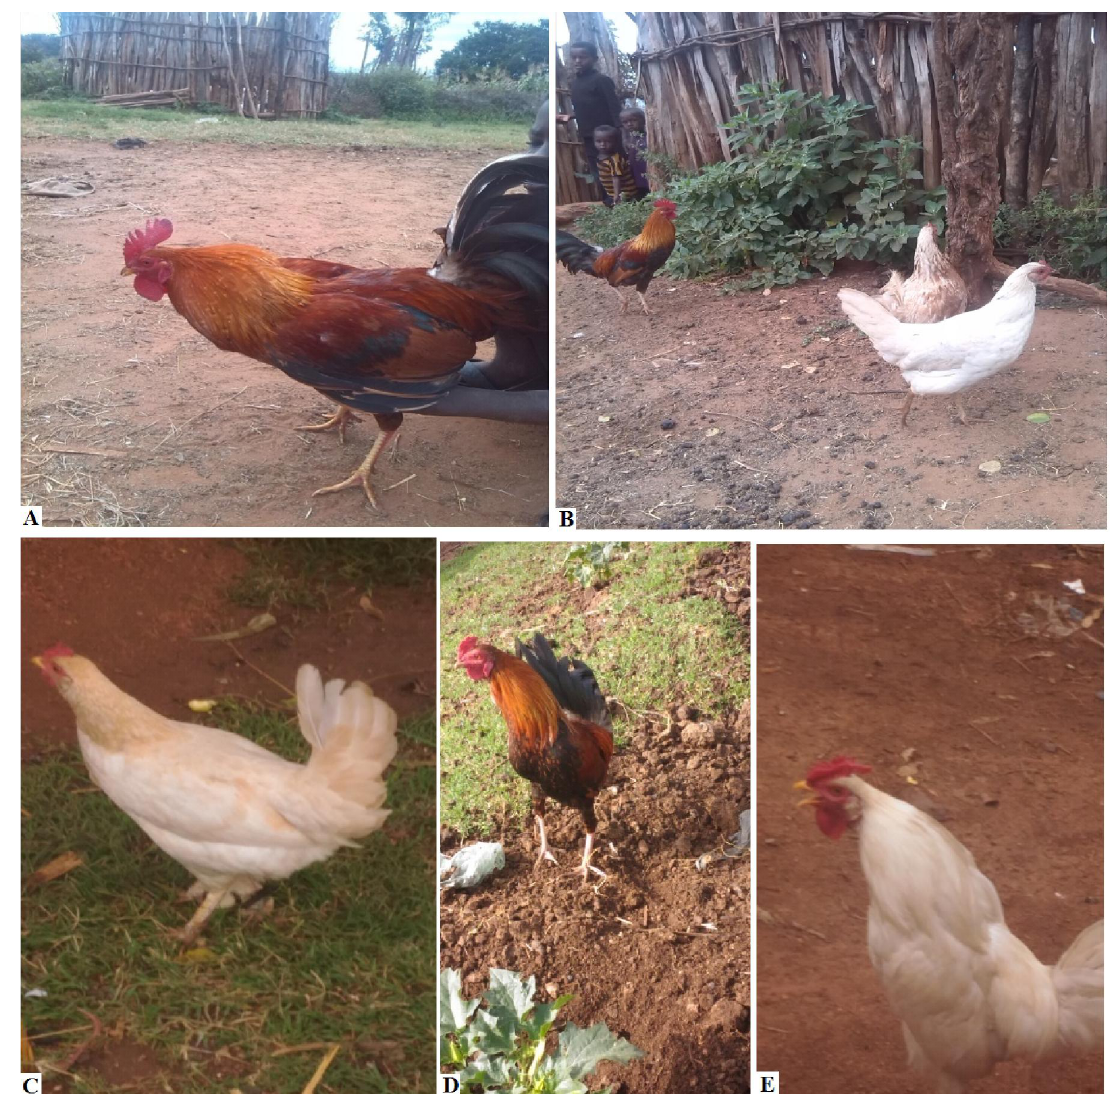
Fig. 2. Typical male and female chicken pictures in study districts: A) Male in Yabello district; B) Female and male in Yabello District; C) Female in Dire district; D and E) Male in Dire district. Morphometric variation (least square mean